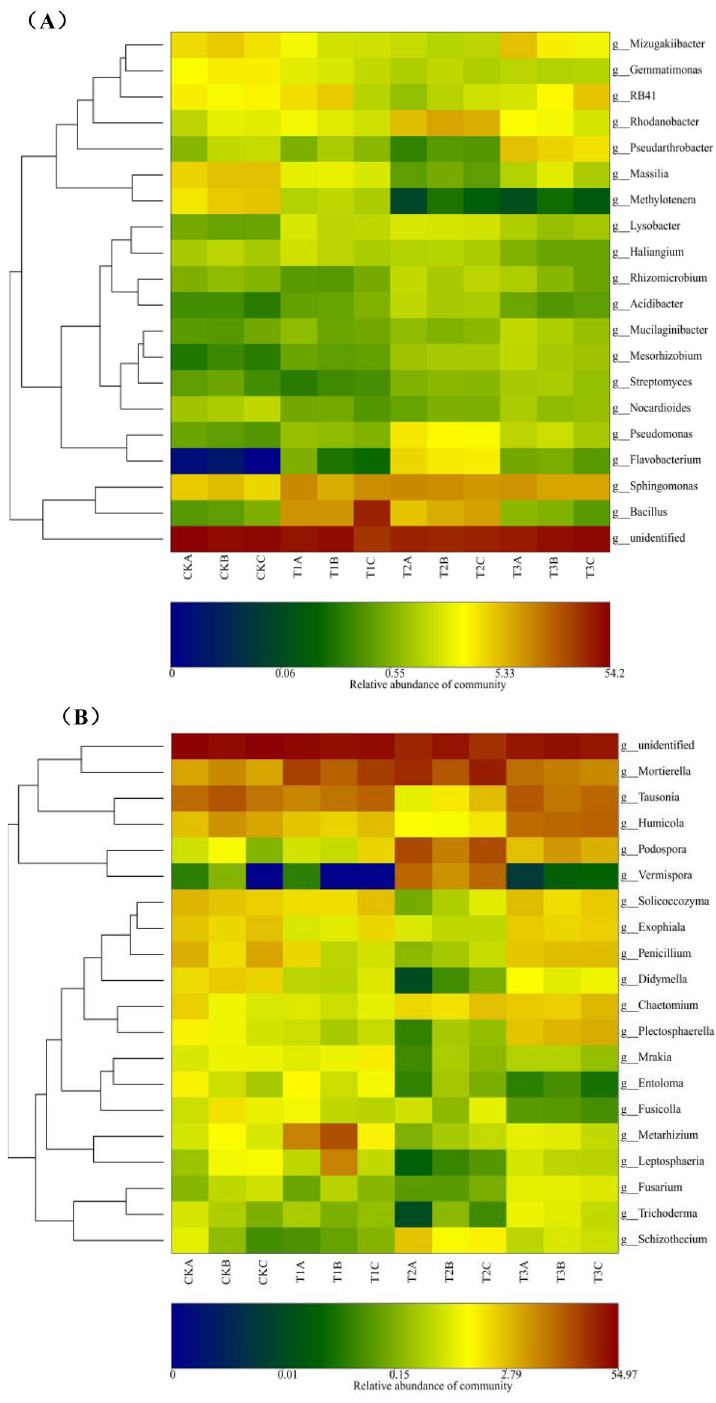
Figure 6. Effect of different treatments on core bacterial (A) and fungal (B) biota at genus